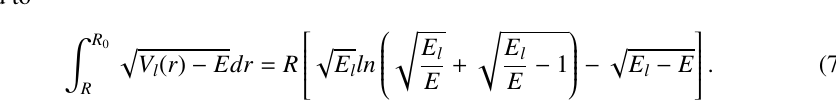
to Γ AS as a function of energy E . n n